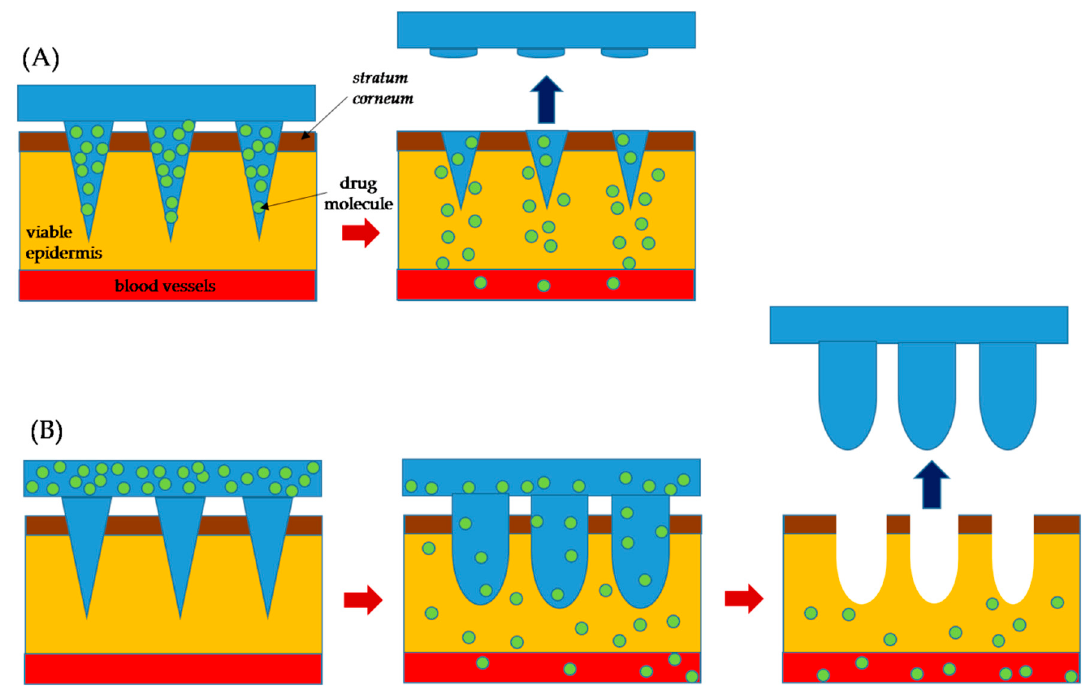
Figure 2. A schematic diagram for the mechanism of drug delivery: ( A ) dissolving MNs and ( B ) swellable MNs. The MN completely dissolve in skin in the case of ( A ), while there is no polymer dissolution in skin for the case of ( B ).